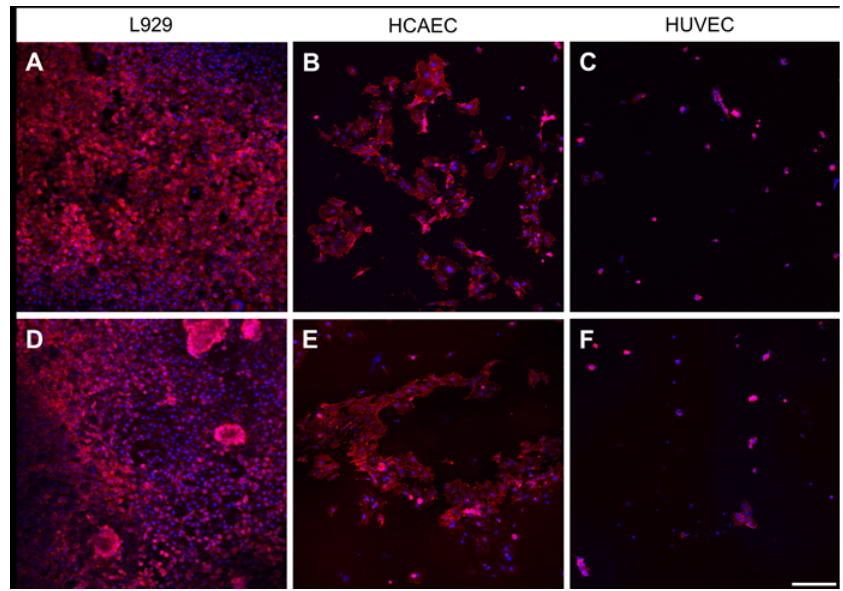
Fig 5. Confocal images of cells grown on two different polymers. Actin filaments are seen in red (phalloidin-staining), cell nuclei in blue (Hoechst-staining) The upper row demonstrates the cell adhesion of L929 (A), HCAEC (B) and HUVEC (C) after incubation on unmodified P(LLA-co-GA).The lower row demonstrates the adhesion of the same cells, L929 (D), HCAEC (E) and HUVEC (F) following incubation on unmodified P(LLA-co-CL). Scale bar = 200 μ